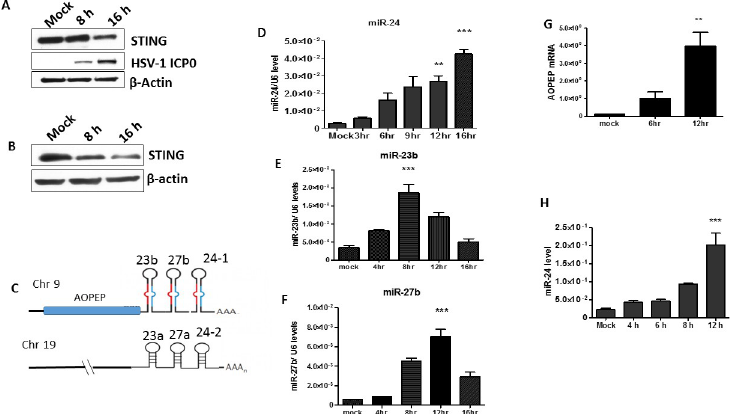
Fig 3. HSV1 infection induces expression of the AOPEP-miR-23b/ miR-27b/ miR-24-1 locus. (A) (B) STING expression was analyzed by western blotting in human (A) HT1080 cells and (B) mouse NB41A3 cells upon HSV1 infection (MOI-5). (C) Figure depicting expression of miR-24 from 2 genetic loci. mir-24 is expressed in clusters from human chromosome 9 (miR-23b/ miR-27b/ miR-24-1) and chromosome 19 (miR-23a/ miR-27a/miR-24-2). Chromosome 9 cluster is expressed along with AOPEP mRNA. Human HT1080 cells were infected by HSV1 and cells were harvested at various time points. (D) miR-24, (E) miR-23b and (F) miR-27b expression levels were measured. (G) The expression of AOPEP mRNA was quantified. (H) Mouse NB41A3 cells were infected by HSV1 and cells were harvested at various time points to determine miR-24 levels. ( D, E, F, G, H : Mean ± SEM, N = 3). � P < 0.05, �� P < 0.01, ��� P <